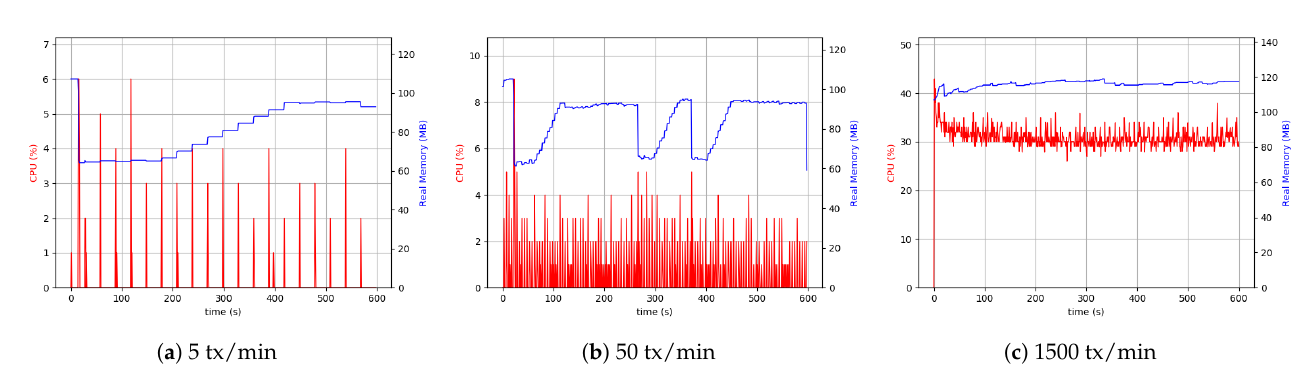
Figure 13. CPU and memory use for varying data sizes for client process in the Desktop